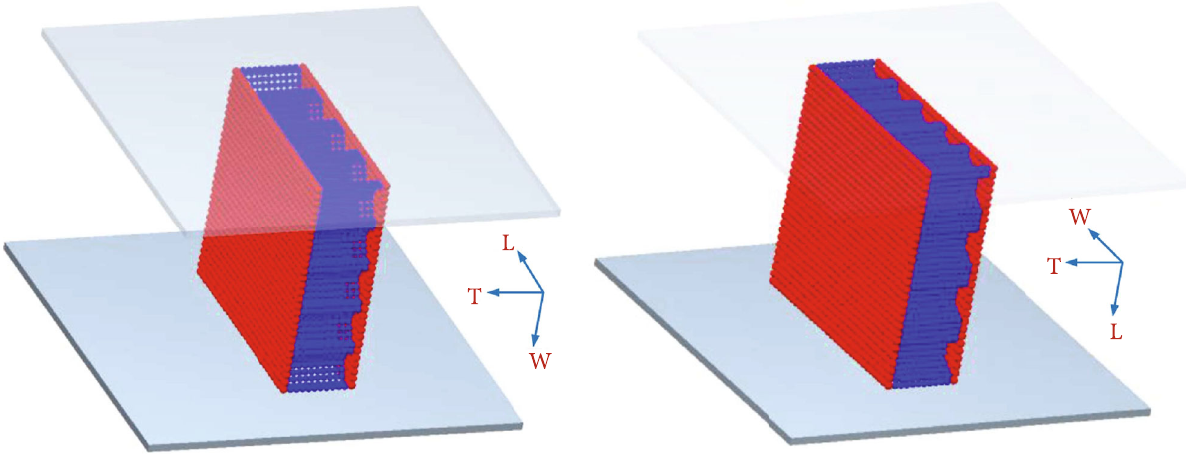
Figure 14: Discrete element square honeycomb coplanar compression model.